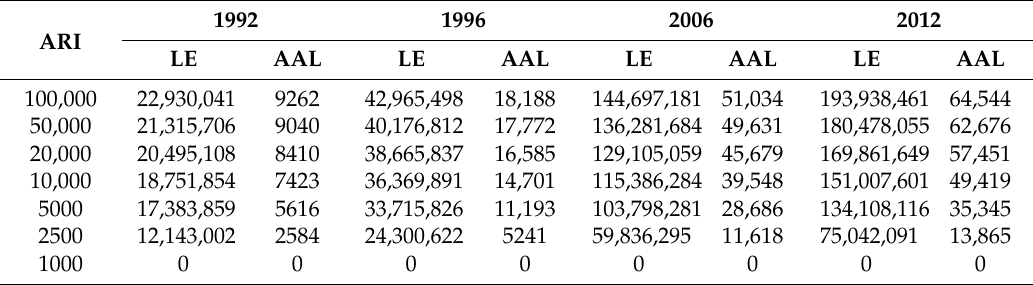
Table 4. Estimated building loss exceedance (LE) and average annual loss (AAL) for each study year